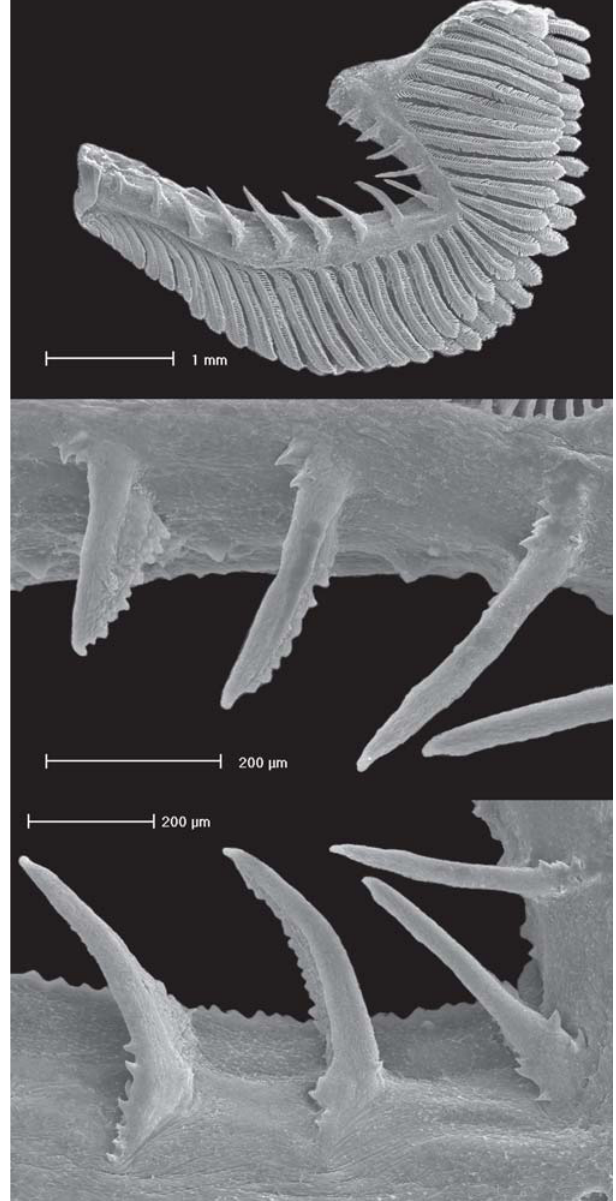
Fig. 28. First gill arch of Odontostilbe parecis , INPA 21425, male 30.6 mm SL. SEM photographs of the left side gill arch (top), in detail gill rakers on upper branchial branch (middle), and gill raker on lower branchial branch (bottom). Lateral